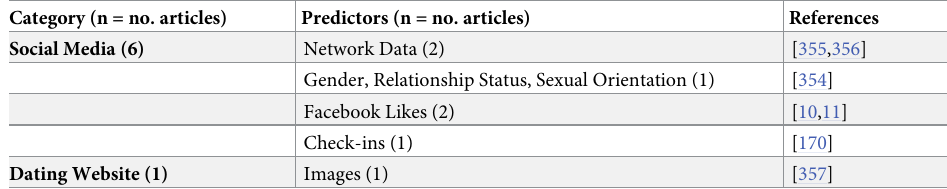
Table 10. Number of articles predicting sexual orientation, with associated predictors and references. Category (n = no.